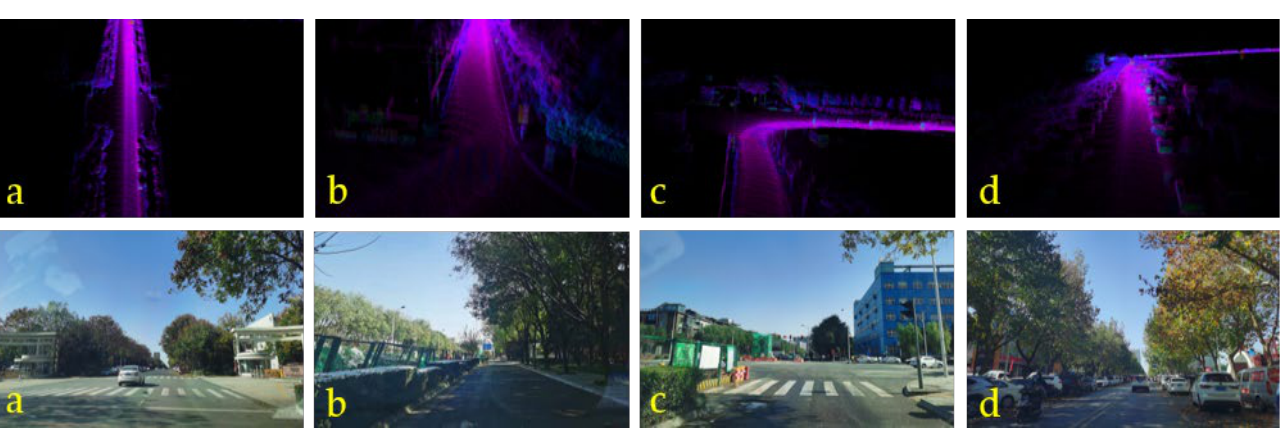
Figure 11. The mapping results on an urban road; ( a – d ) show the point cloud map of the lidar and the matched image information. The shooting position is shown in four places ( a – d ) in Figure 10.